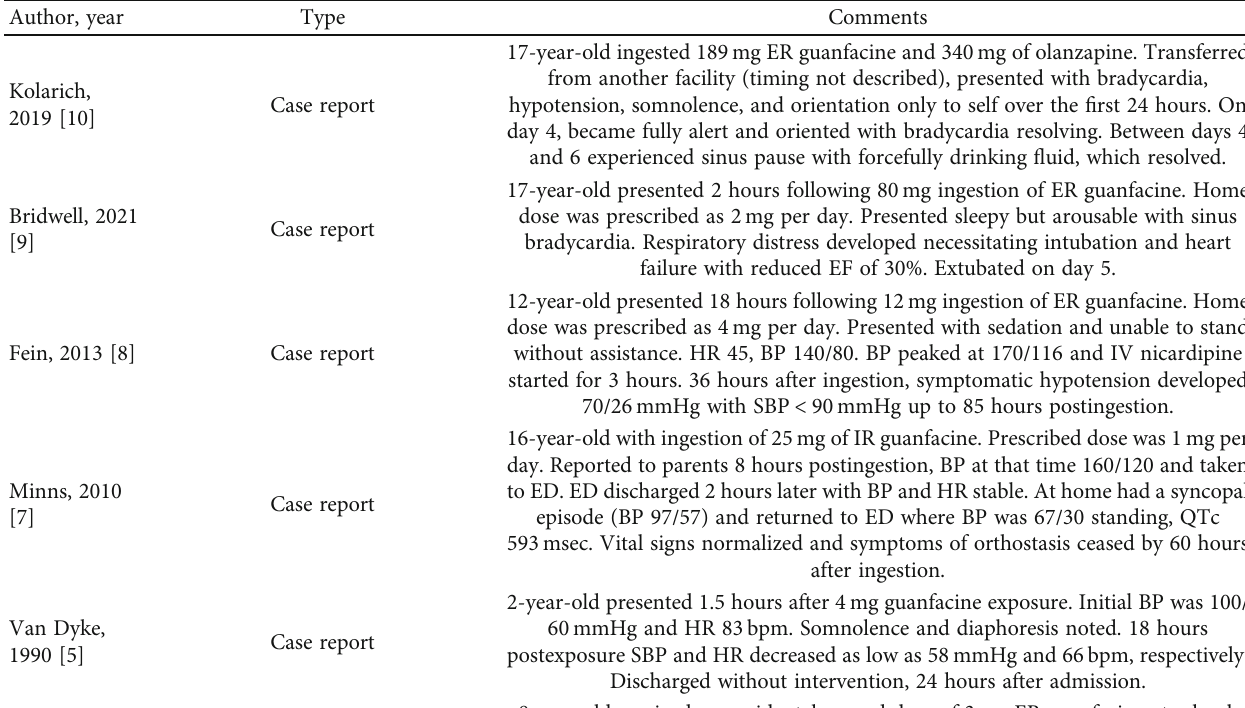
Table 1: Review of